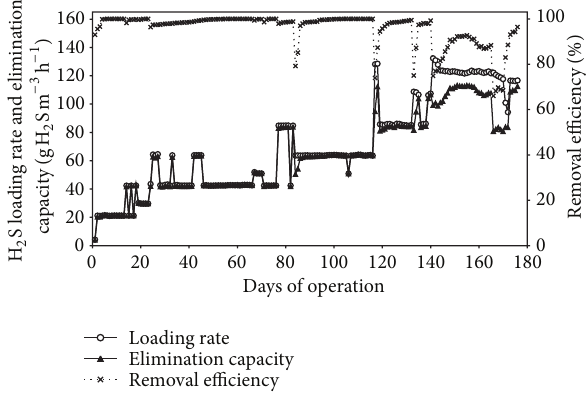
Figure 2: Daily performance of the airlift bioreactor over the study